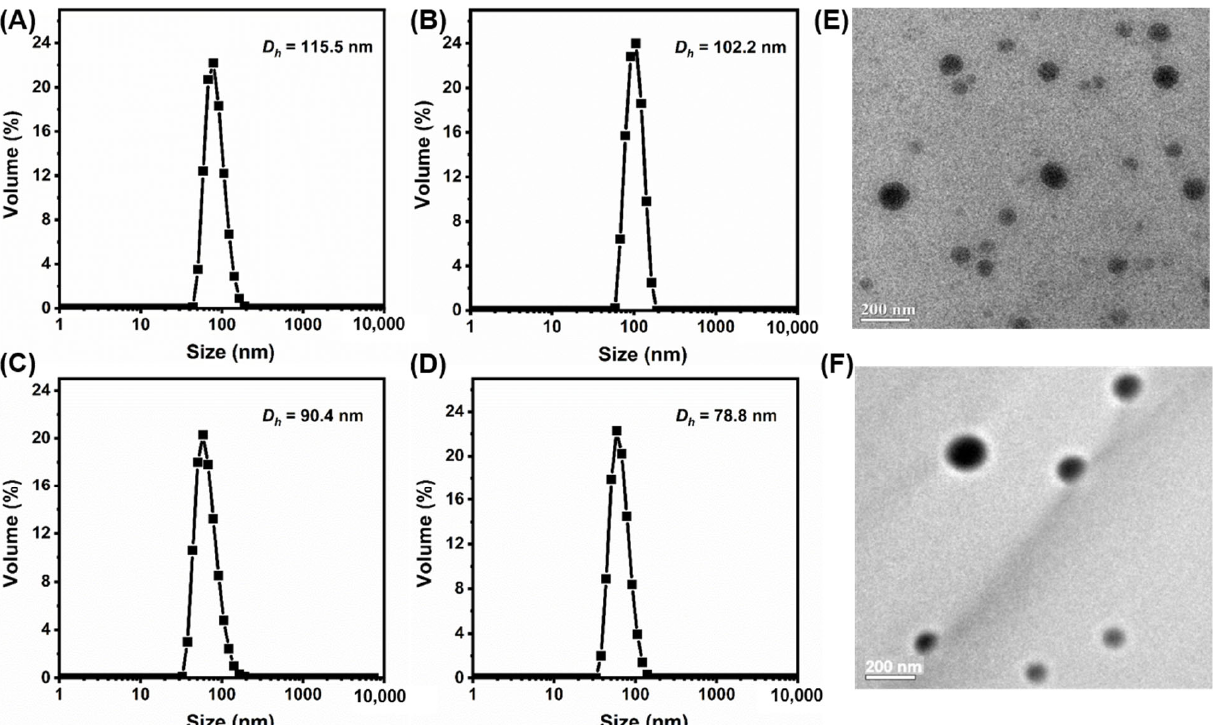
Figure 2. DLS diagrams of PEG- b -P(HEMA-ene)- b -PBA-based nanoparticles: ( A ) NCM, ( B ) CM5, ( C ) CM10, and ( D ) CM20 in water. TEM images of ( E ) NCM and ( F ) NCM5. Table 2. Preparation of PEG ‐ b ‐ P(HEMA ‐ ene) ‐ b ‐ PBA ‐ based micelles with tunable crosslinking den ‐ sity at core ‐ shell interface.